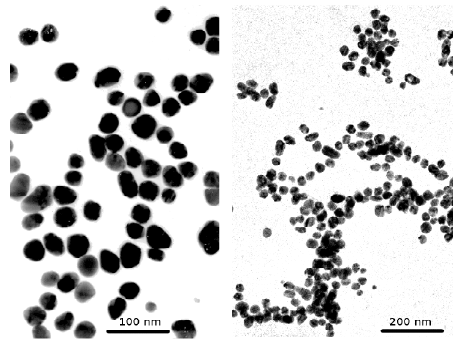
Figure 10. TEM images of resultant silver nanoparticles obtained using the characteristic